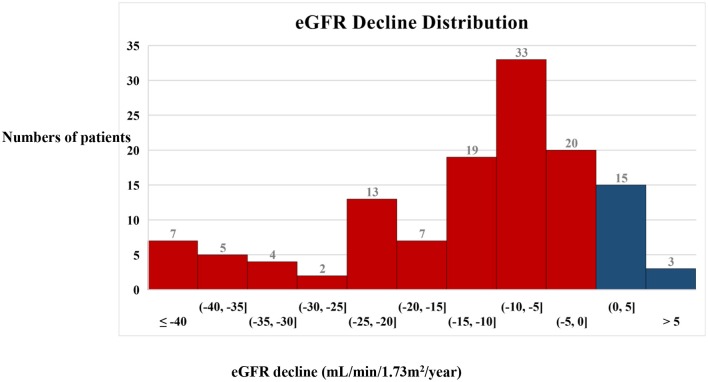
Distribution of the annual decline in eGFR in the patients. A histogram showing the distribution of the annual decline in eGFR in the patients. Blue bars indicate an increase in eGFR and red bars indicate a decrease in eGFR.